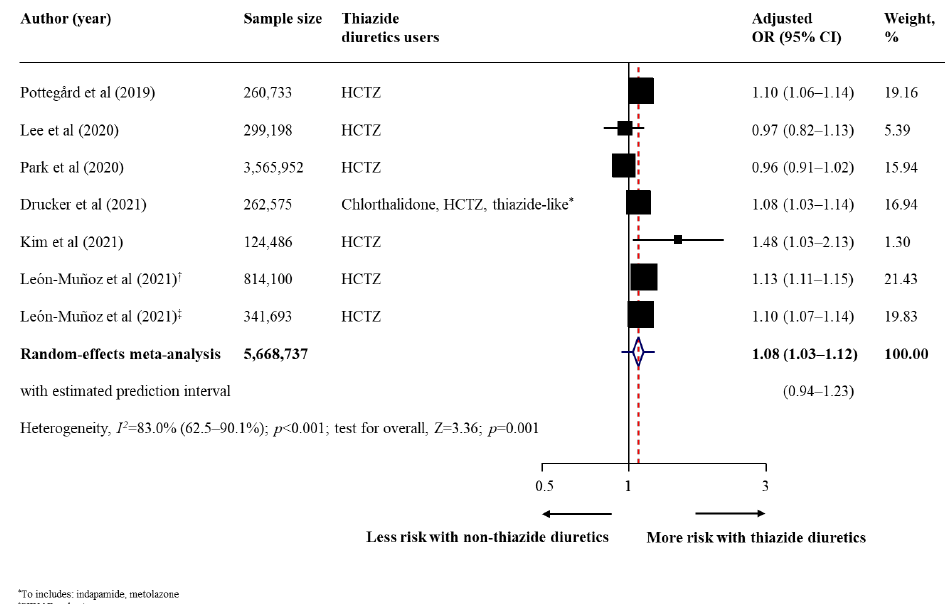
Figure 4. Effect of using thiazide diuretics and the risk of unspecified non-melanoma skin cancer. Abbreviations: CI, confidence interval; HCTZ, hydrochlorothiazide; OR, odds ratio